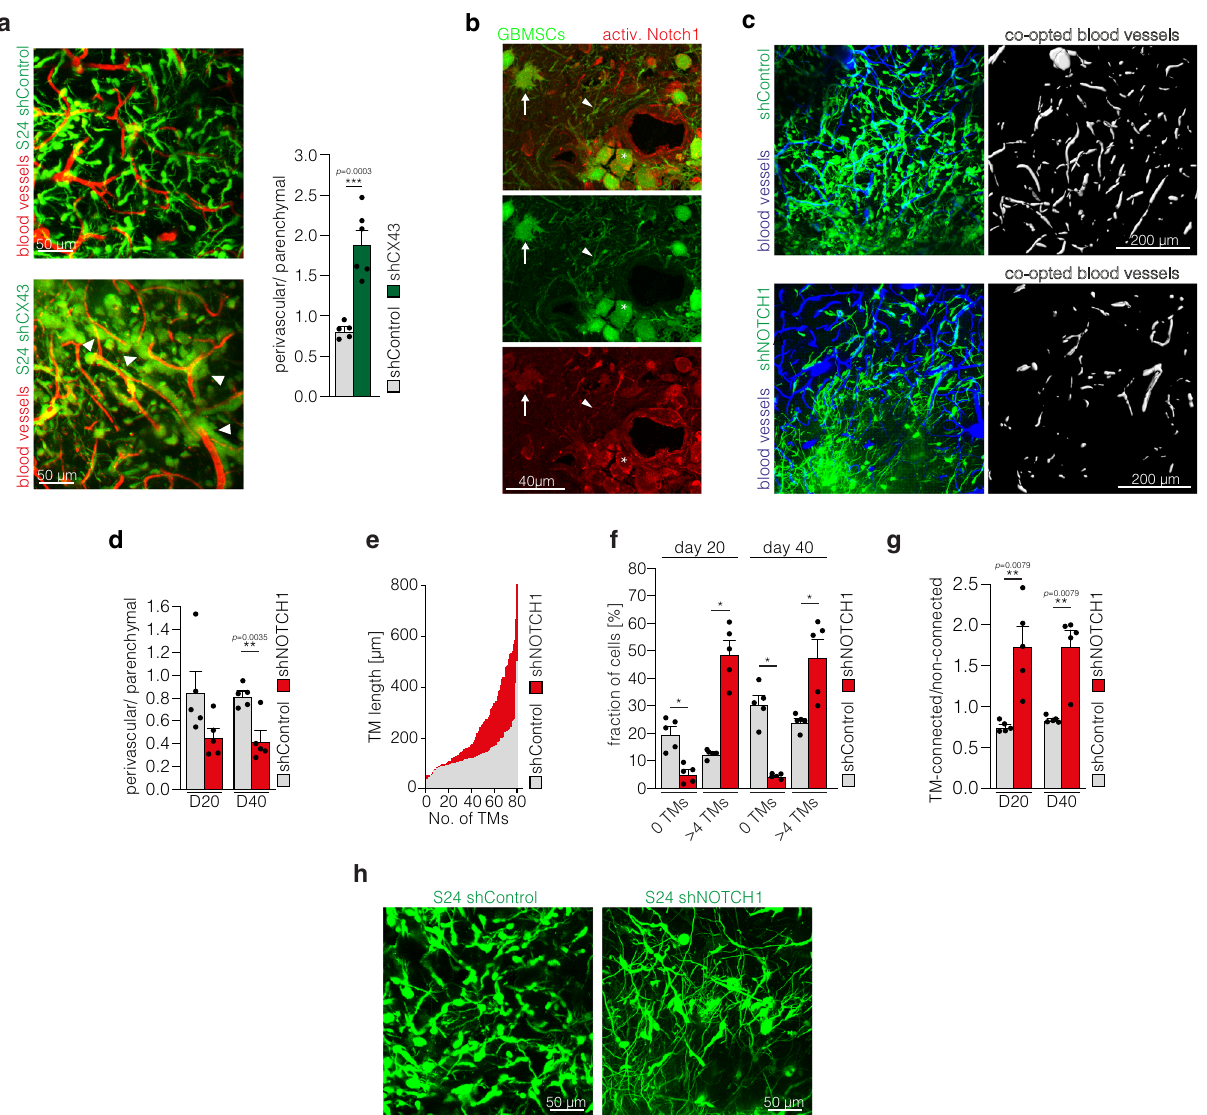
Fig. 6 NOTCH1 inhibition leads to depletion of the perivascular niche but promotes TM-network formation. a Left: Exemplary in vivo 2-PM images of S24 shControl (top, D40) and shCX43 tumors (bottom, D43). Right: Corresponding ratio of perivascular and parenchymal cells in S24 shControl and shCX43 knockdown tumors (D40±4, n = 5 regions (S24 shControl)/6 regions (S24 shCX43) in 3 mice per group, two-tailed t -test). b Immuno fl uorescence staining of activated Notch1 in a S24 tumor section. Arrow: multi-TM parenchymal cell (low Notch1 activation); arrowhead: Notch1-low TM; asterisk: perivascular cell (high Notch1 activation). c Exemplary 2-PM images of S24 shControl (top) and shNOTCH1 (bottom) glioblastoma stem-like cells (GBMSCs) (green) with segmentation of co-opted blood vessels (white) demonstrating a reduced population of the perivascular compartment after NOTCH1 downregulation (D24±1). Blood vessels (blue). d Ratio of the perivascular and parenchymal cell count 20 and 40 days after S24 shControl and shNOTCH1 tumor cell implantation ( n = 5 regions in 3 mice (S24 shControl)/4 mice (S24 shNOTCH1), 38 – 445 cells, two-tailed t -tests). e Histogram and quanti fi cation of TM length in S24 shControl and shNOTCH1 GBSMSCs (D20, n = 3 mice (S24 shControl), n = 4 mice (S24 shNOTCH1). f Quanti fi cation of TM-devoid (0 TMs) vs. TM-rich (>4 TMs) S24 shControl and shNOTCH1 GBMSCs ( n = 5 regions in 3 mice (S24 shControl)/4 mice (S24 shNOTCH1), 18 – 286 cells, one-way ANOVA on the ranks ( p = 2.90×10 − 12 ), Student – Newman – Keuls post hoc test). g Ratio of connected and non-connected S24 shControl and shNOTCH1 GBMSCs 20 and 40 days after tumor cell implantation ( n = 5 regions in 3 mice (S24 shControl)/4 mice (S24 shNOTCH1), 11 – 245 cells, two-tailed Mann – Whitney tests). h Corresponding 2-PM images demonstrating the TM richness of S24 shNOTCH1 tumors (D40). Data a , d , f , g are represented as mean + SEM. * p <0.05, ** p <0.01, *** p < 0.001. Source data are provided as a Source Data fi le. Analysis of differential mRNA expression of human gliomas . RNA sequencing cardially perfused with 4.5% phosphate-buffered formaldehyde solution (Roti- Histo fi x 4.5%, 2213, Carl Roth). Tissue was frozen after cryoprotection with 30% data of molecular (1p/19q-codeleted, IDH mutant) oligodendroglioma ( n = 56) sucrose solution and 10 µm cryosections were cut. The sections were permeabilized and molecular (1p/19q non-codeleted, IDH wild-type) glioblastoma ( n = 70) was with 0.5% Triton X-100 in PBS for 20 min. The EdU Click Kit (BCK488-IV-IM-S, downloaded from TCGA and analyzed as described previously 15 . The full list of baseclick GmbH) was used for EdU detection. After washing, sections were differentially expressed genes can be found in Osswald et al. (2015) 15 . incubated with the reaction cocktail for 30min as per the manufacturer ’ s instructions. Afterwards sections were incubated with anti-nestin (1:400, ab6320, Abcam, RRID:AB_308832) and anti-CD31 (1:50; PA5-16301, ThermoFisher Sci- In vivo EdU incorporation . Animals were treated with 50 mg/kg EdU i.p. enti fi c, RRID:AB_10981955) antibodies.Goat anti-rabbit Alexa Fluor 594 (1:400; (BCK488-IV-IM-S, baseclick GmbH) 4h prior to euthanasia. Animals were NATURE COMMUNICATIONS| (2021) 12:1014